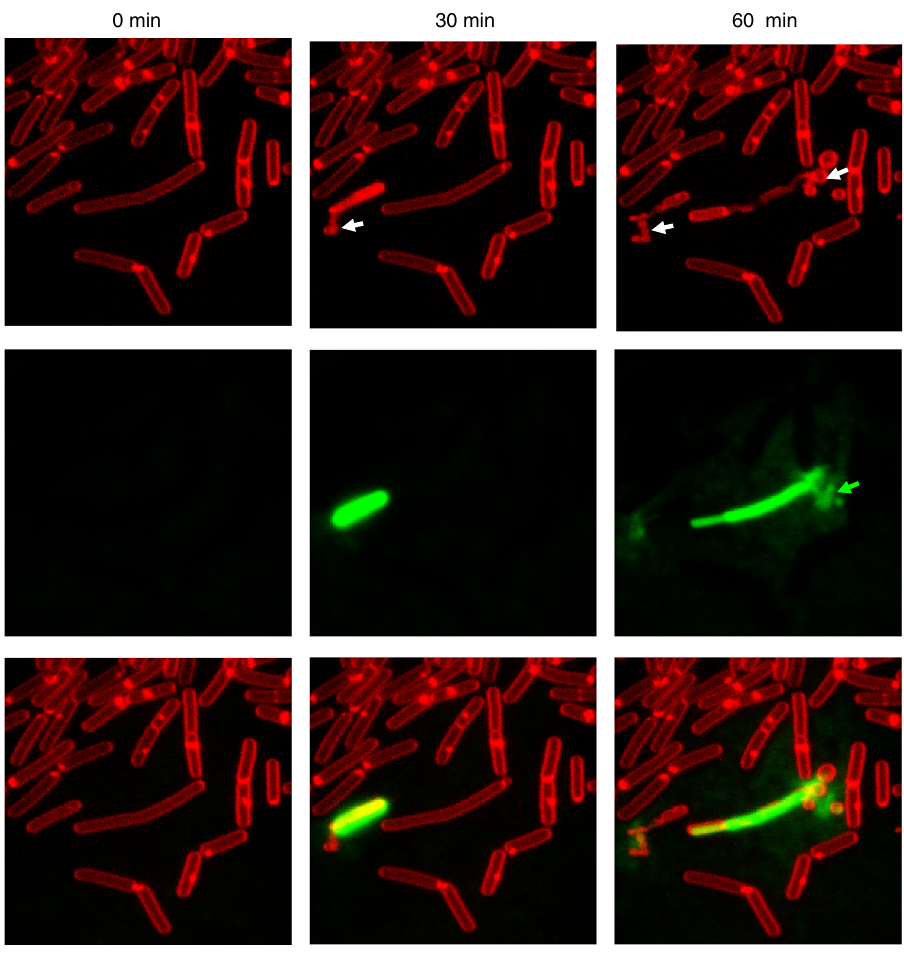
Fig. 1 MVs are released by B. subtilis 168 at the onset of cell death. MV formation was followed at 30 min intervals at room temperature. Membranes were stained with the red fl uorescent dye FM4-64 and SYTOX green was used to visualize dead cells and extracellular DNA (green). White arrows indicate cells releasing MVs and green arrows indicate extracellular DNA. Scale bar , 5 μ